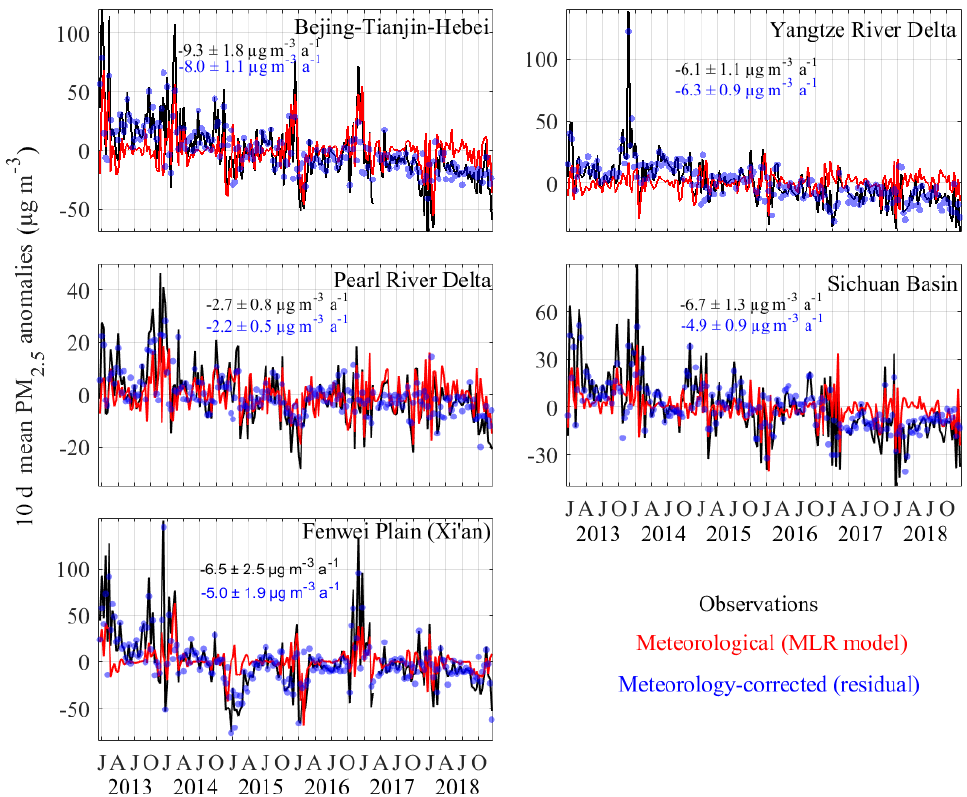
Figure 6. Time series of 2013–2018 PM 2 . 5 10d mean anomalies for the five target regions of Fig. 1. The anomalies are relative to the 2013–2018 means. The data are averaged over all measurement sites in each region with at least 70% of data coverage for each year (same as for Fig. 2). The meteorological contribution to the anomalies as determined from the MLR model is shown in red. The long-term trend in the meteorology-corrected residual in blue (Eq. 3) is interpreted as being driven by changes in anthropogenic emissions. Values inset in each panel are the ordinary linear regression trends, with 95% confidence intervals obtained by the bootstrap